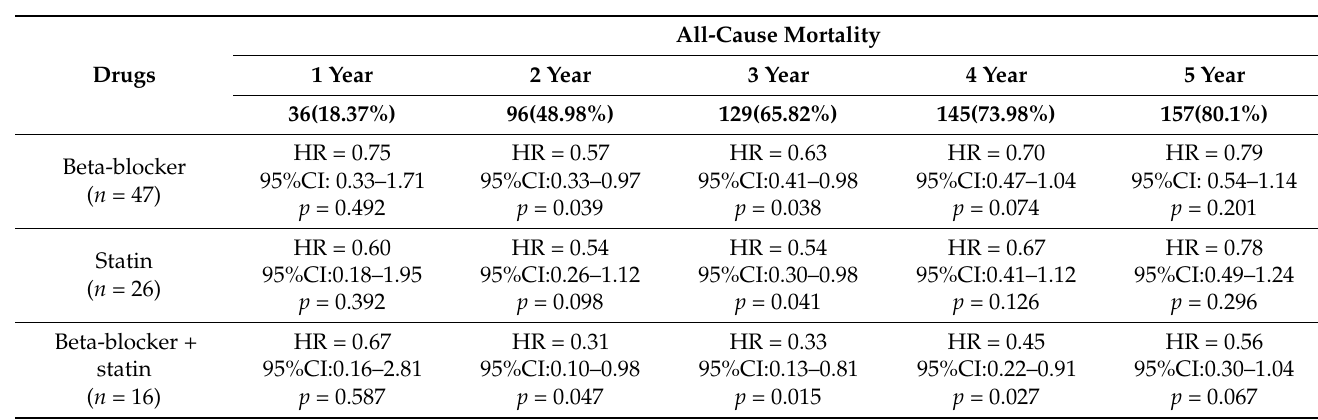
Table 3. Therapies due to cardiovascular reasons and all-cause